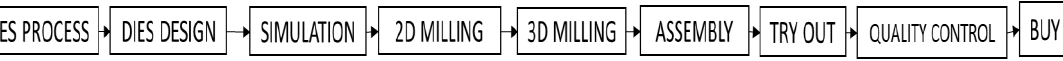
Figure 3: Dies process